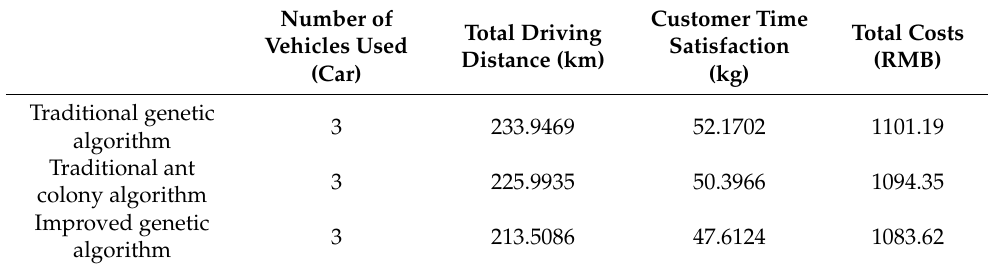
Table 9. Comparison of calculation results.